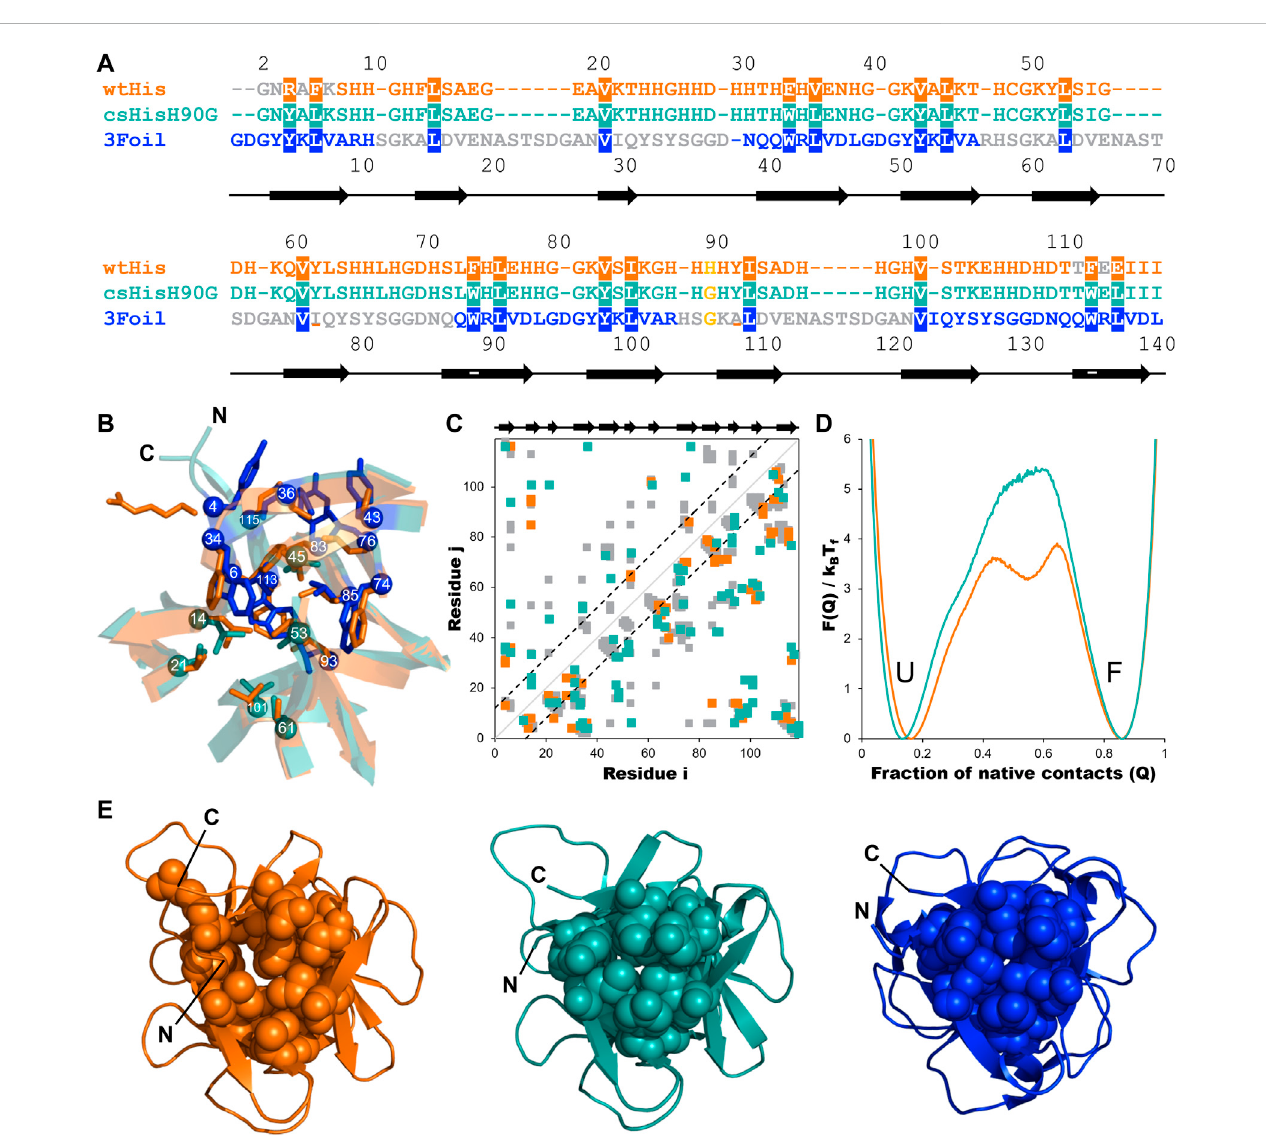
FIGURE 3 Engineering long-range intramolecular contacts between core residues enhances the hisactophilin unfolding free energy barrier. Hisactophilin (wtHis; orange) core residues were replaced with those of ThreeFoil (3Foil; blue) to give the core-swapped hisactophilin variant csHisH90G (cyan). (A) Sequences for wtHis,csHisH90G,and3Foilaregivenasastructure-basedsequencealignmentwiththe18conservedcoreresiduestargetedforengineeringhighlighted.The thermodynamically stabilizing point mutation H90G is yellow. Secondary structure for wtHis and csHisH90G is indicated below the alignment, with β - strands represented as arrows. Residue numbers for wtHis and csHisH90G are given above the alignment. Residue numbers for 3Foil are given below the alignment. wtHis and 3Foil residues that were excluded from structural templates used in Rosetta Comparative Modeling to generate the csHisH90G model are in grey. Residues used to monitor changes in protein fl uorescence (Y62 and Y92 in wtHis; W34, W74, and W113 in csHisH90G; W42, W89, and W136 in 3Foil) are underlined. (B) wtHis and csHisH90G are overlaid to illustrate mutated core residues. wtHis core residues are given in orange. csHisH90G core residues derived from 3Foil are shown in blue, and csHisH90G core residues that are unchanged from wtHis (i.e., equivalent 3Foil residues already had the sameaminoacid identityaswtHis)aregiven incyan.C α atoms areshown asspheres andarenumberedaccordingtothealignmenttowtHis givenin (A) .Loop residues are removed for simplicity. (C) Difference contact map for wtHis and csHisH90G. Contacts commonto both proteinsare shown in grey. The top left portion shows contact pairs made by core residues to any other residue. The bottom right portion shows all residue pairs for each protein. Long-range contacts, in which residues i and j are more than 11 residues apart in the primary sequence, are all contacts outside of the back dashed lines. Secondary structure is indicated above the contact map. C α contact maps were generated using the Shadow map algorithm available through SMOG2 using default parameters(i.e.,6 Åmaximumcontactcutoffand1 Åatomocclusion)(Noeletal.,2012;2016).AllsimulationsforwtHisandcsHisH90Gwerecompletedusing SMOG2shadowmaps. (D) wtHisand csHisH90Gunfoldingfreeenergybarriersweresimulated usingC α -SBMs. Simulationswererunateachprotein ’ sfolding temperature, and unfolding free energy barriers were solved using the Boltzmann reweighting method described by Gosavi et al. (2006). Unfolding free energy barriers are given along the reaction coordinate Q, the fraction of native contacts. The unfolded (U) and folded (F) states are indicated. The unfolding